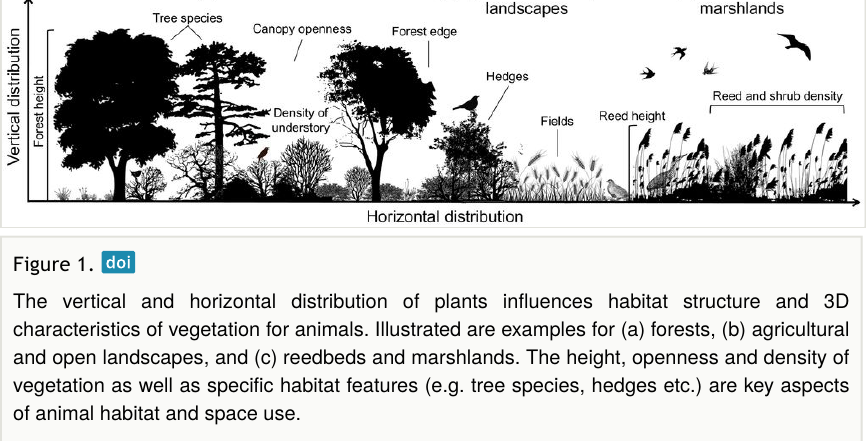
A major bottleneck for predictive biodiversity modelling is the current lack of high-resolution (i.e. fi ne-scale) measurements of habitat structures and 3D characteristics of vegetation across regions and continents (Davies and Asner 2014, Dantas de Paula et al. 2016, Lausch et al. 2016). Animals depend on the vertical and horizontal distribution of plants at di ff erent spatial scales (Fig. 1), ranging from regional habitat distributions to 3D vegetation structure within local habitats (Cody 1985, Wiens 1989, Buler et al. 2007, Kissling et al. 2008, Fuller 2012). However, current studies usually do not account for this hierarchical nature of animal-habitat associations (Kristan III 2006) because they either use only coarse habitat information (e.g. CORINE land cover types) over large spatial extents or very local information with a fi ne grain but a small spatial extent. For instance, the CORINE Land Cover database (http://land.copernicus.eu/pan-european/corine-land-cover), a widely used data source, provides consistent geographical information on land cover across Europe, but only distinguishes 44 coarse land cover classes (e.g. only three forest and fi ve wetland types). Small and scattered habitats such as reedbed and linear elements (e.g. hedges) in agricultural landscapes are generally not well represented, and the 3D structural and compositional characteristics of land cover types are not captured at all. This is insu ffi cient for modelling species distributions of animals because their abundances as well as nesting and foraging requirements depend on the fi ne-scale structure of the landscape (e.g. density, cover and openness of vegetation, edges) (Cody 1985) and on the speci fi c 3D characteristics of the habitats (e.g. vertical and horizontal distribution of biomass) (MacArthur and MacArthur 1961, Goetz et al. 2010, Lesak et al. 2011, Zellweger et al. 2013) (Fig. 1). Hence, high-resolution measurements of 2D and 3D ecosystem structures at fi ne grain sizes are needed across broad spatial extents (regional to continental) to make major advancements in animal ecology and biodiversity science (Wulder et al. 2004, Kissling et al. 2008, Vierling et al. 2008, Zhang et al. 2013, Dantas de Paula et al. 2016, Zellweger et al. 2016).